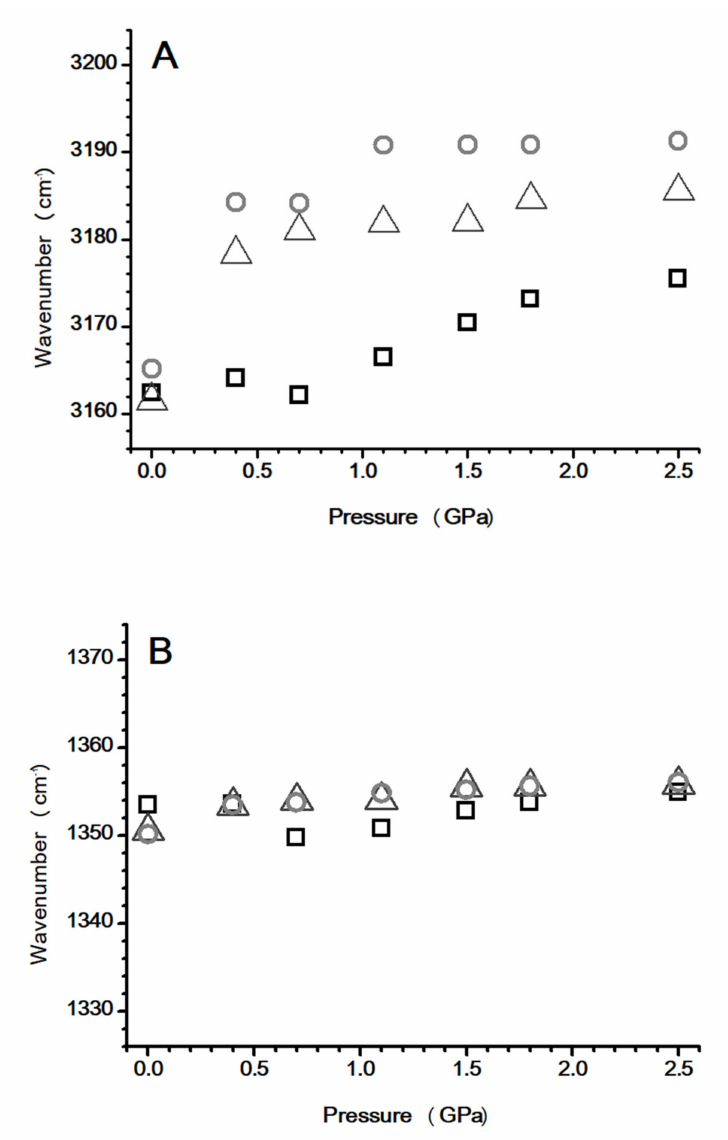
Figure 9. Pressure dependence of the C–H stretching frequencies for ( A ) imidazolium C 4,5 –H and ( B ) anionic ν a SO 2 of pure [EMIM][NTf 2 ] (squares) and the [EMIM][NTF 2 ] / PVdF-co-HFP mixtures with 50 wt.% (triangles) and 10 wt.% (circles) of [EMIM][NTf 2